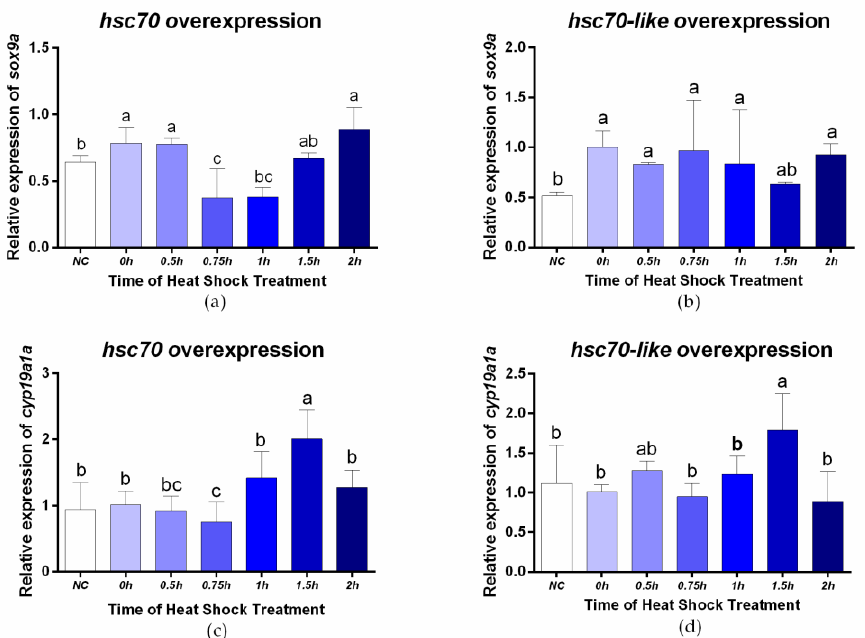
Figure 8. Analysis of sex-related genes after the overexpression of target genes under heat shock treatment. ( a , b ) Relative expression of sox9a in C. semilaevis testis cell line overexpression with hsc70 ( a ) / hsc70-like ( b ); ( c , d ) Relative expression of cyp19a1a in C. semilaevis testis cell line overexpression with hsc70 ( c ) / hsc70-like ( d ). After transfection with pcDNA3.1- hsc70 /pcDNA3.1- hsc70-like for 24 h, 28 °C heat shock treatment was conducted and lasted for 2 h. pcDNA 3.1 plasmid was set as negative control (NC). Relative expression results were shown as the means ± SEM ( n = 3), and β -actin was normalized as an internal standard. Different lowercase letters indicated statistically significant differences ( p < 0.05).